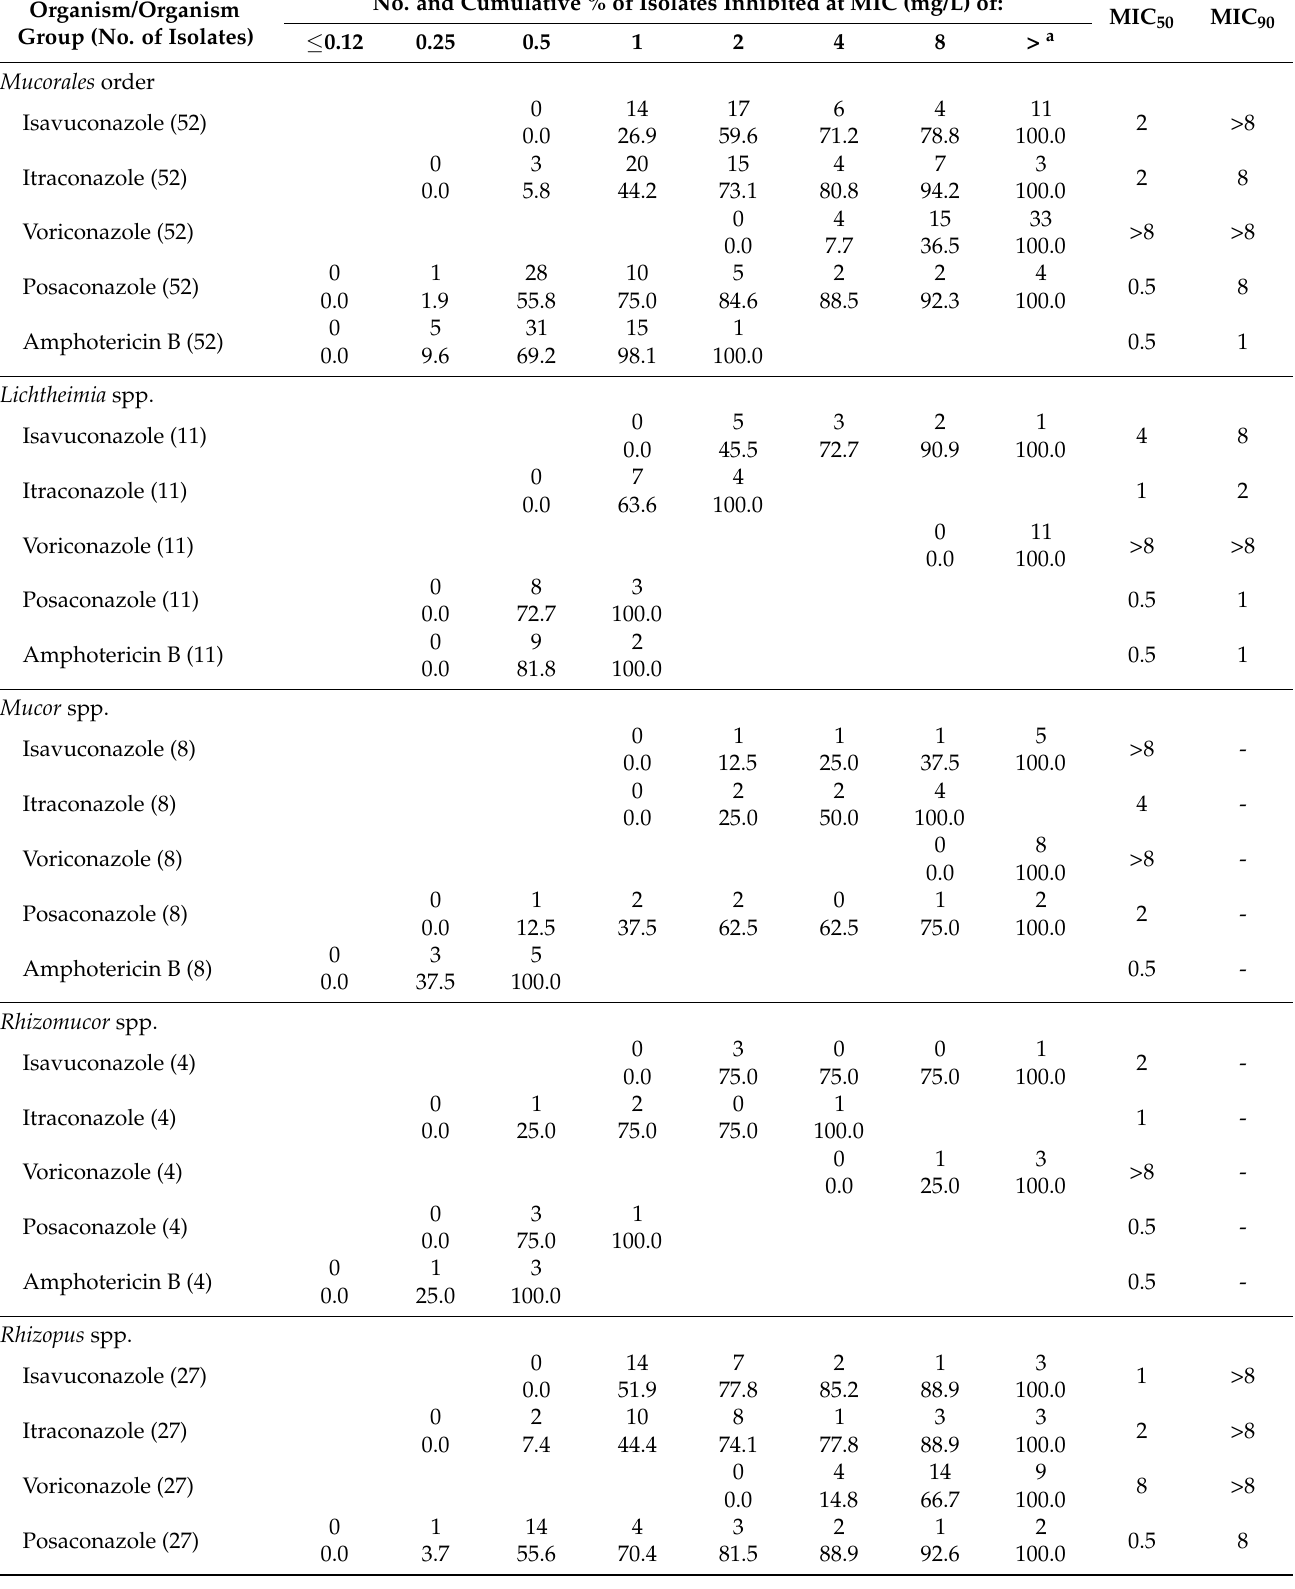
Table 1. Activity of isavuconazole and comparator agents against Mucorales isolates causing invasive infections worldwide